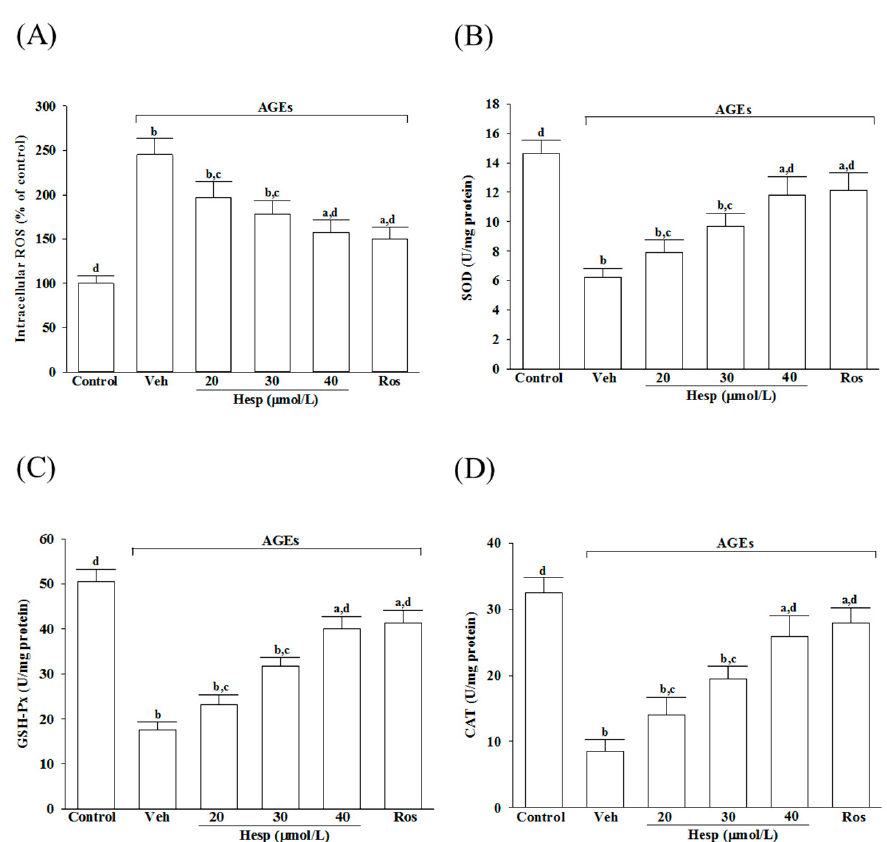
Figure 2. Influences on the ROS level and the antioxidant enzymes activities in SH-SY5Y cells under AGE stimulation. Cells were received 1 h pretreatment with hesperetin (hesp; 20–40 μ mol/L) or rosiglitazone (Ros; 10 μ mol/L), continued to 24 h AGE (200 μ g/mL) exposure. ( A ) Intracellular ROS level was measured by the oxidation-sensitive fluoroprobe DCFH-DA. The activities of ( B ) SOD, ( C ) GSH-Px, and ( D ) CAT were qualified by commercial assay kits. The results are presented as the mean ± SD of five independent experiments performed triplicate (n = 5). a p < 0.05 and b p < 0.01 when compared to the data from the untreated control group (control). c p < 0.05 and d p < 0.01 when compared to the data from the vehicle (Veh)-treated cells.